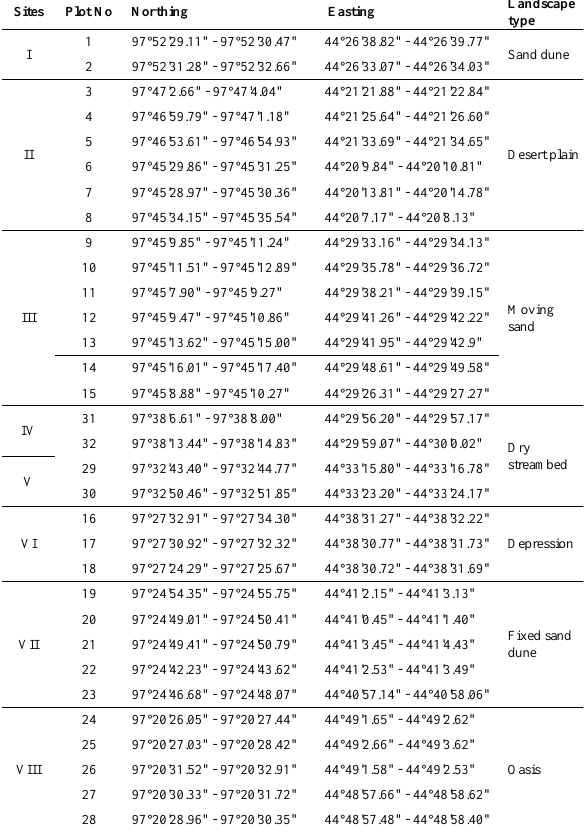
Table 1. Coordinates and landscape characteristics of the study sites.